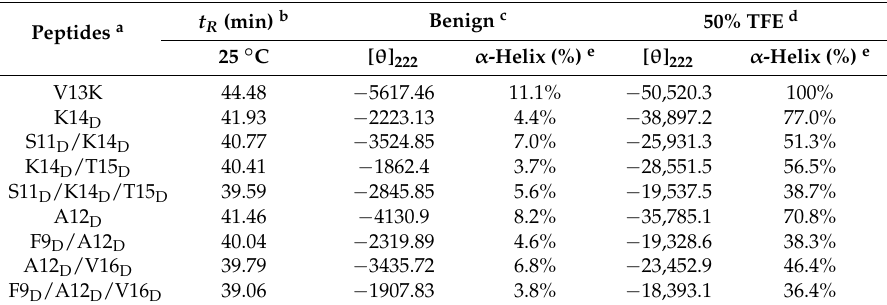
Table 2. Biophysical data of the peptide